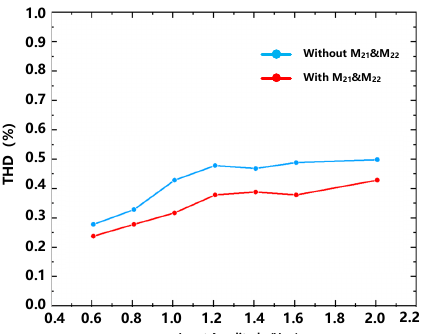
Figure 8. The output voltage with/without C N . The result shows that with the ‘negative’ capacitance the output of the integrator can set up faster. Figure 9 summarizes the improvement in linearity due to this effect at different magnitudes.